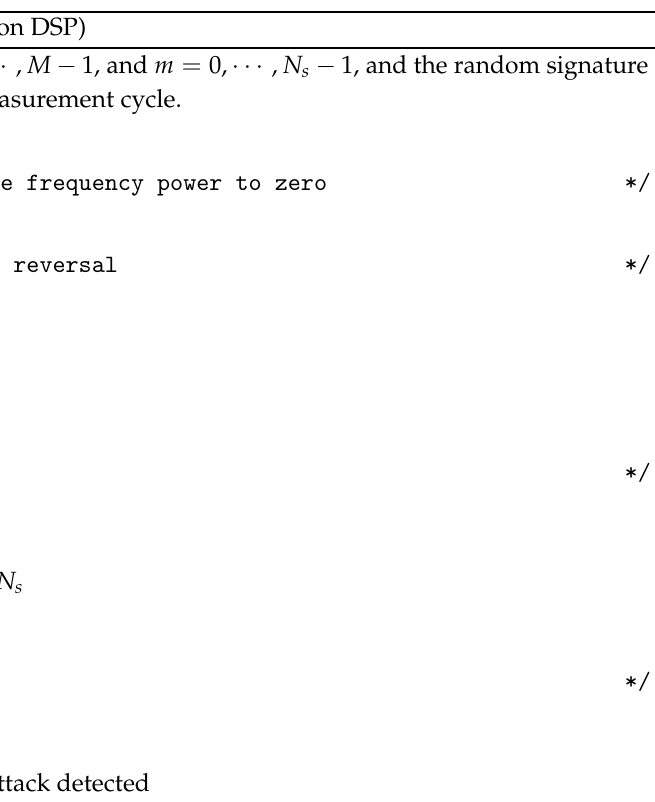
Algorithm 1: Detector (a.k.a. Detection